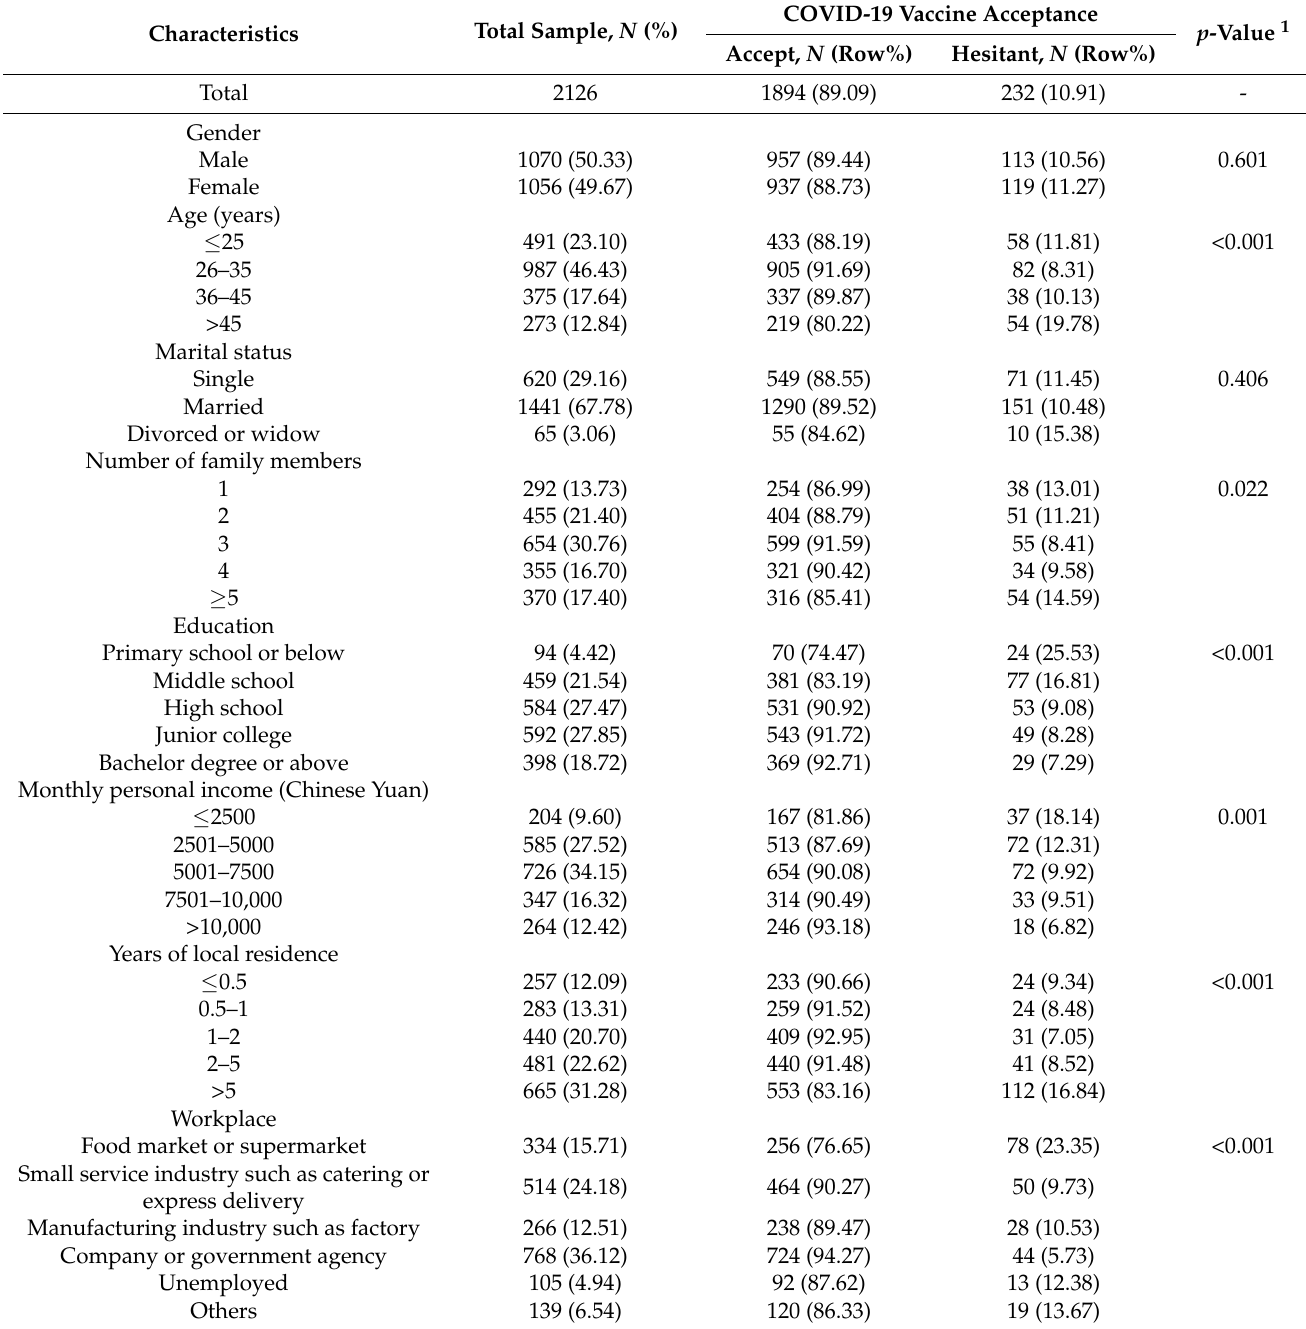
Table 1. Respondent characteristics and COVID-19 vaccine acceptance, N =